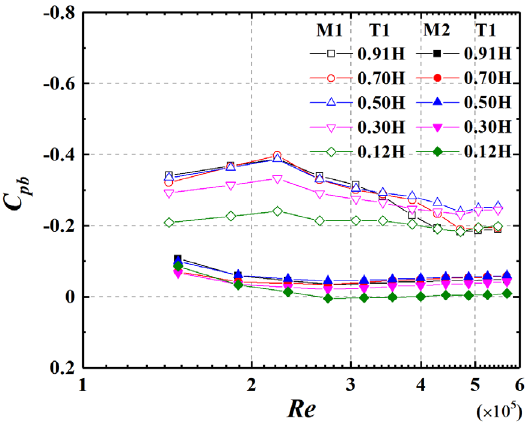
Figure 7. The variation of the base pressure coefficient with Re at different height of models.